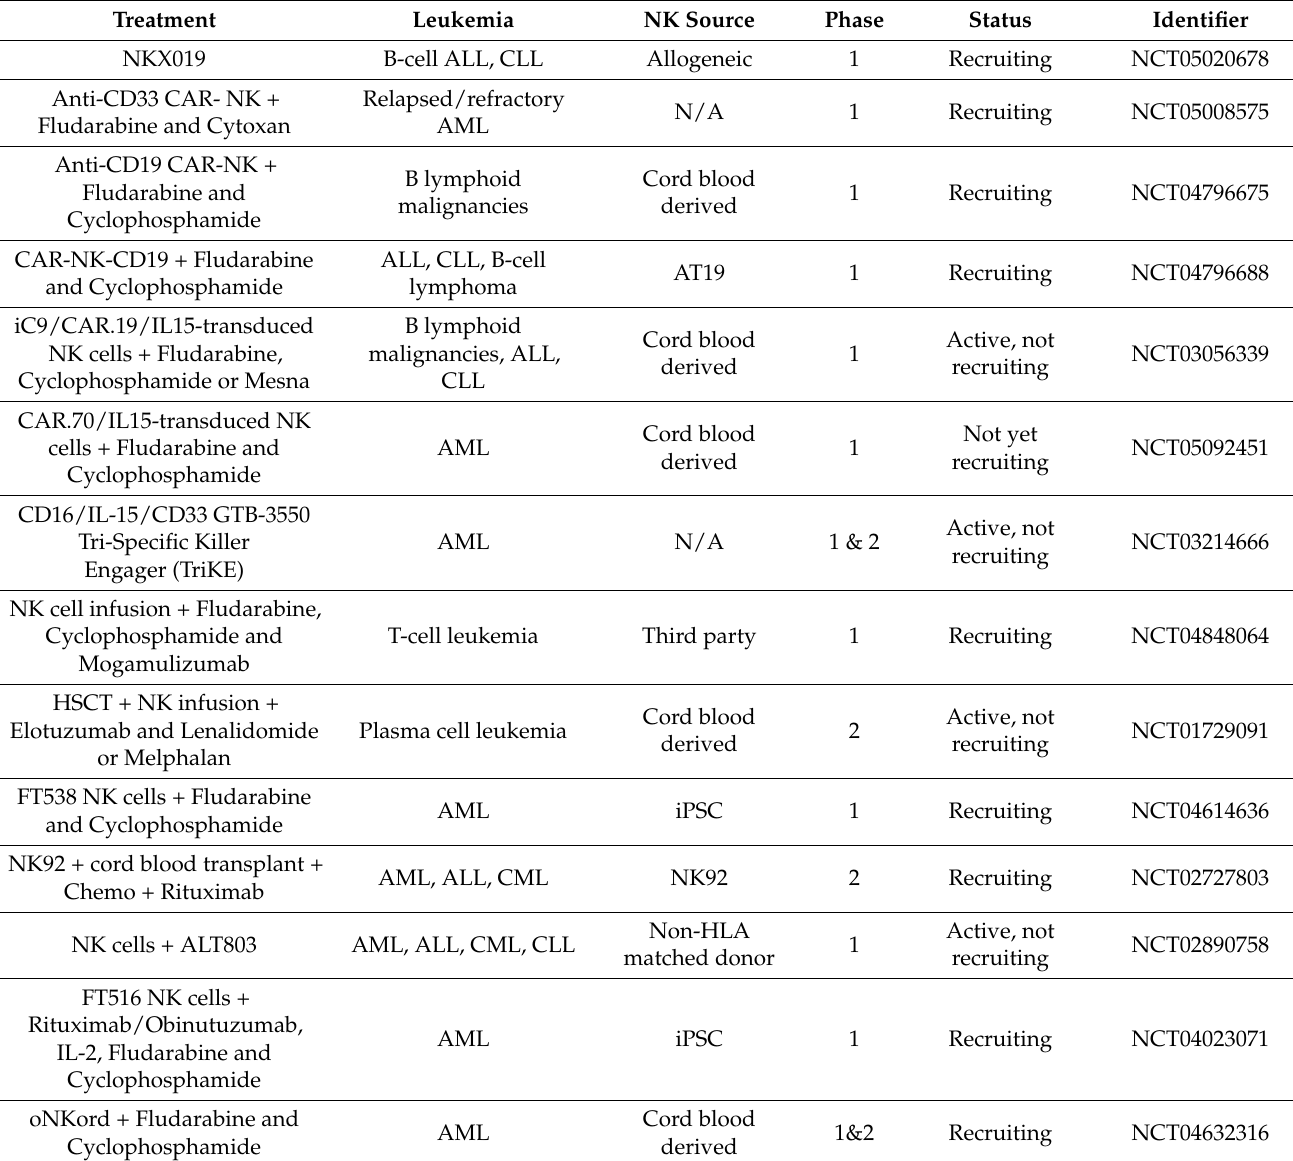
Table 1. Current NK-cell immunotherapy clinical trials for